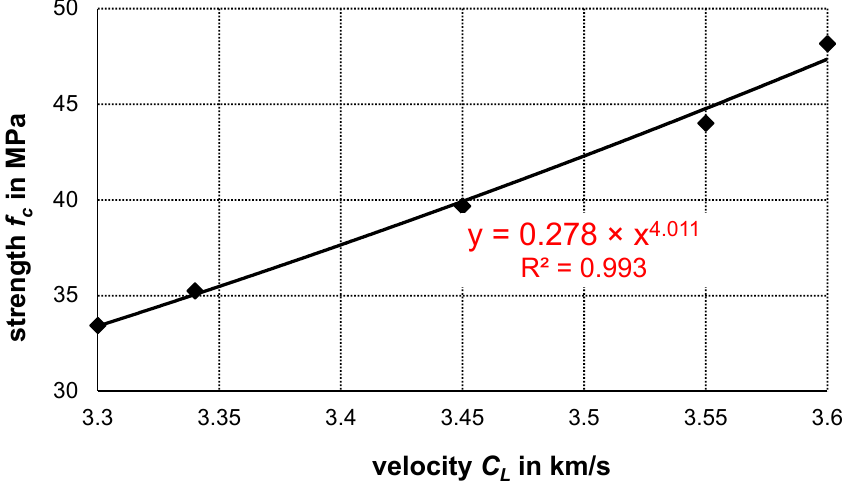
Figure 8. Correlation of concrete compressive strength an ultrasonic wave velocity.